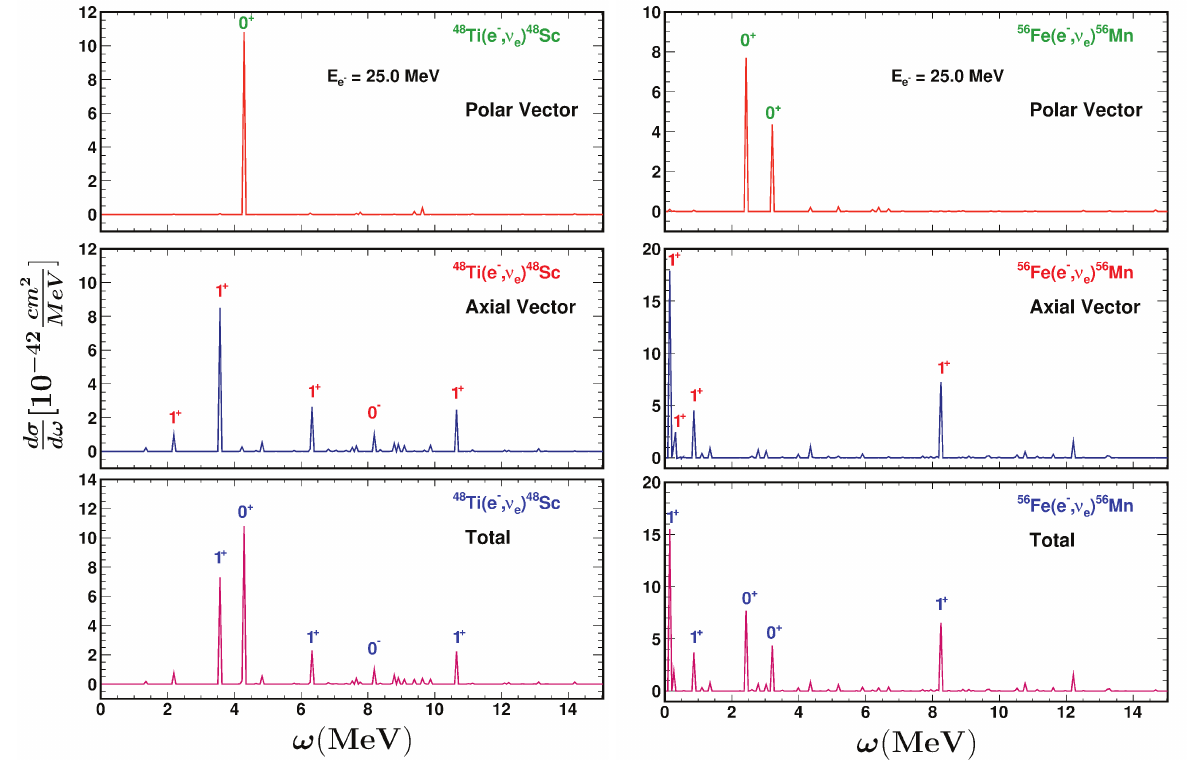
Figure 2. The same as Figure 1 but for the 48 Ti and 56 Fe nuclei.